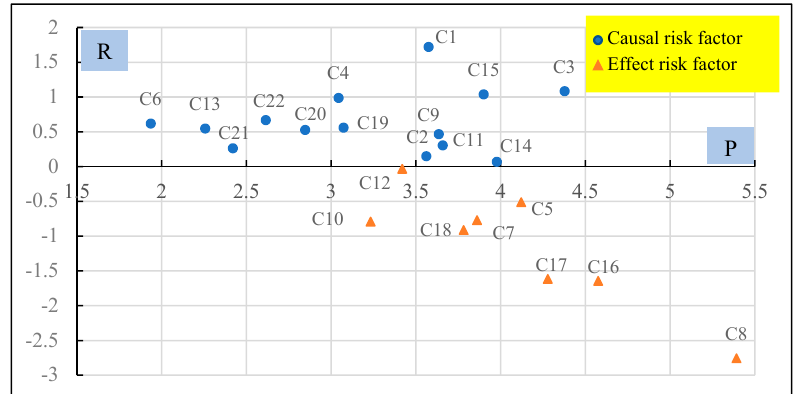
Figure 4. The cause–effect diagram of risk factors in EVCI-PPPs. Note: the criteria with values of R > 0 are in the causal group, whereas those with R < 0 are in the effect group. R—relation; P—prominence.